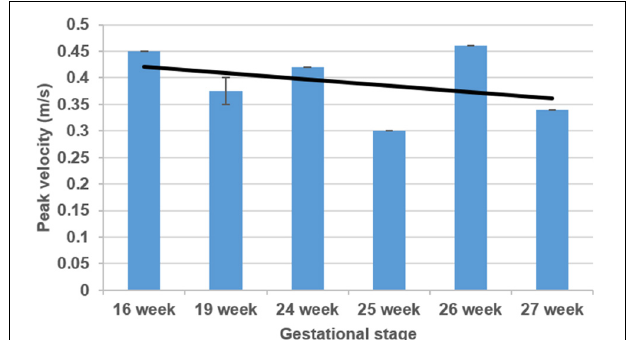
FIGURE 5 | Five sequential mitral valve flow waveforms measured using Doppler ultrasound for each fetal heart. The first half of the last waveform is highlighted in red, which is showing the local maximum and peak flow velocities.